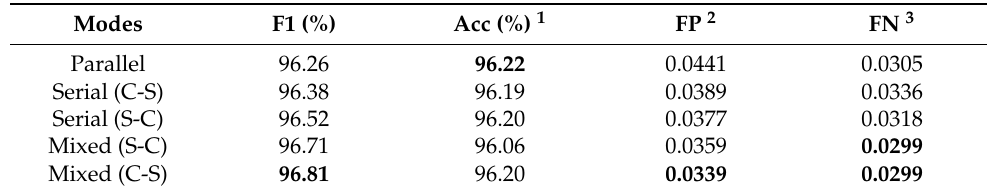
Table 3. Experimental results with different modes for STAM. The number of frames is 4 and multi-frame pre-alignment is